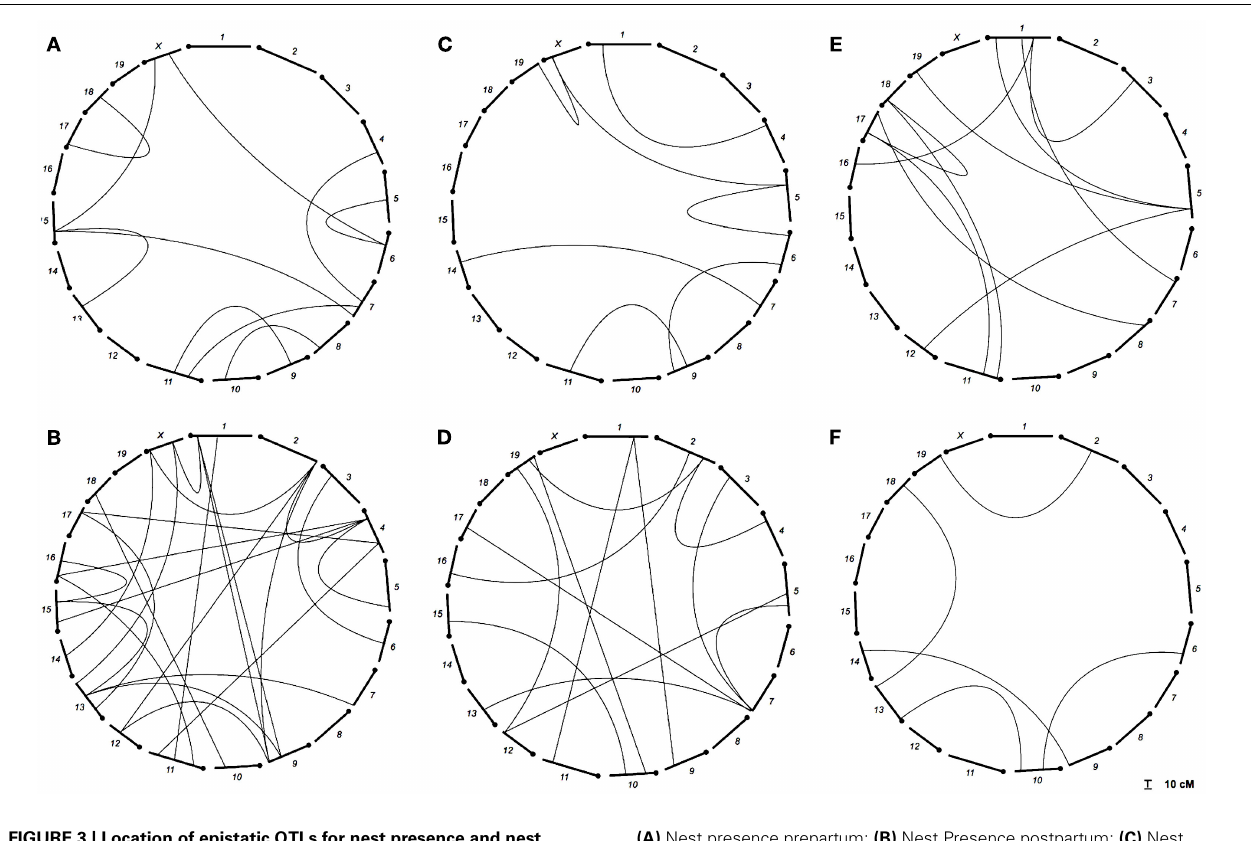
FIGURE 3 | Location of epistatic QTLs for nest presence and nest structure pre- and postpartum, material used prepartum, and temperature difference postpartum across the total 20